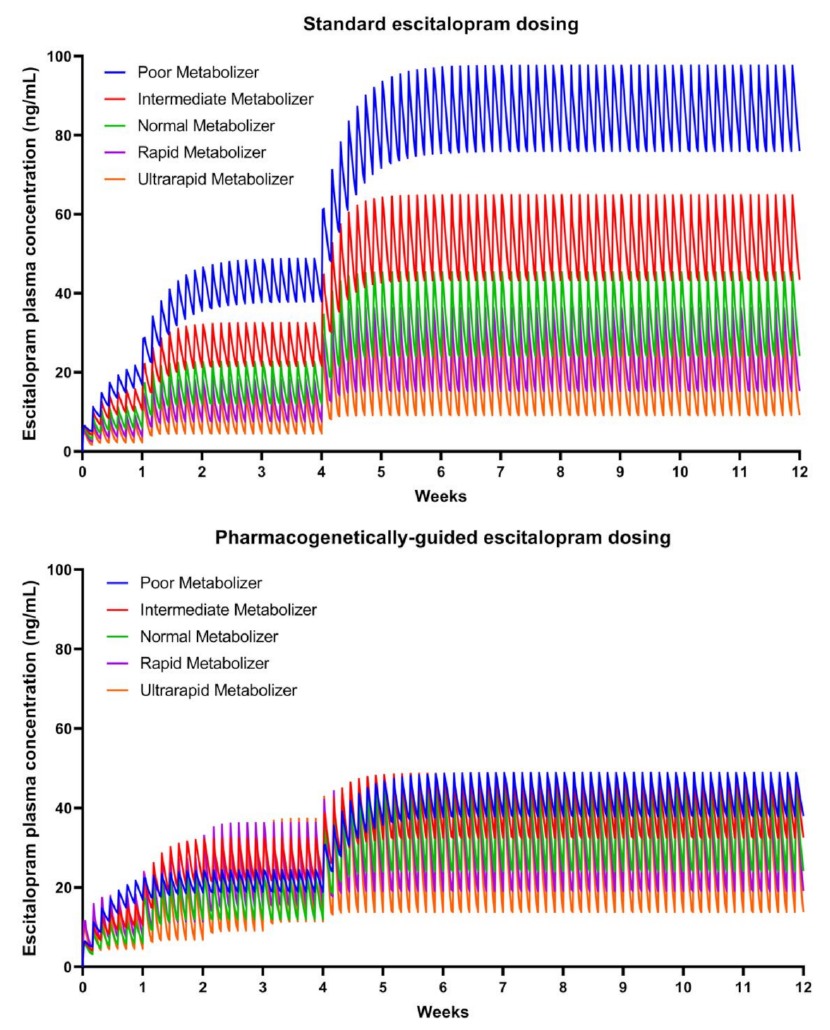
Figure 2. Standard ( top ) and pharmacogenetically-guided dosing ( bottom ) in adolescents result in considerable variation and harmonization of the concentration–time curves, respectively. Adapted from Strawn et al.,